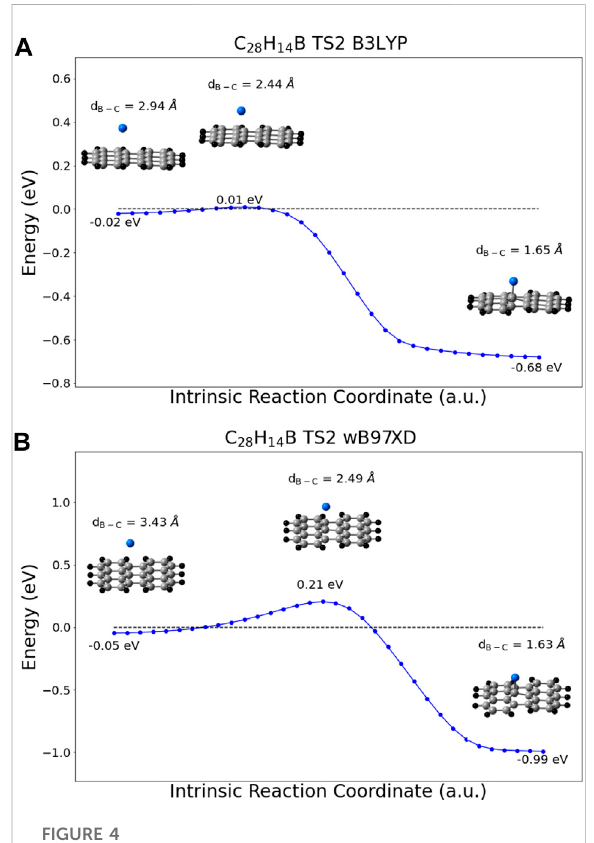
FIGURE 4 IRCscansfollowingthereactionfromtheweaklyphysisorbed state (left) over the transition state (center) to the fully adsorbed state (right) calculated with the (A) B3LYP/cc-pVDZ method and (B) wB97XD/cc-pVDZ method. The energies depicted are in reference to the energy of the fully separated products, and no zero-point energy corrections have been made. Carbon = Grey, Hydrogen = Black, and Boron =